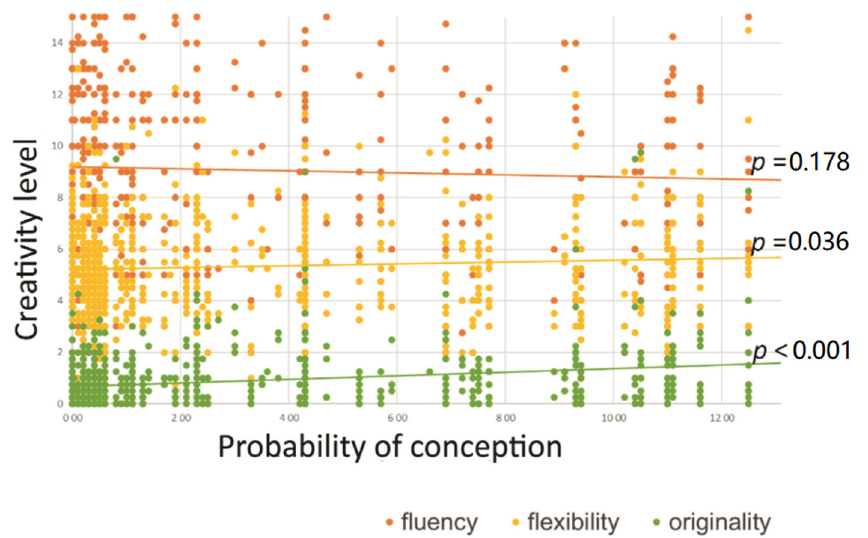
Figure 1. The linear relationship between the probability of conception and creative fluency, flexibility and originality.